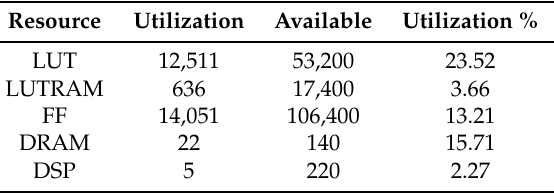
Table 5. Utilization summary.